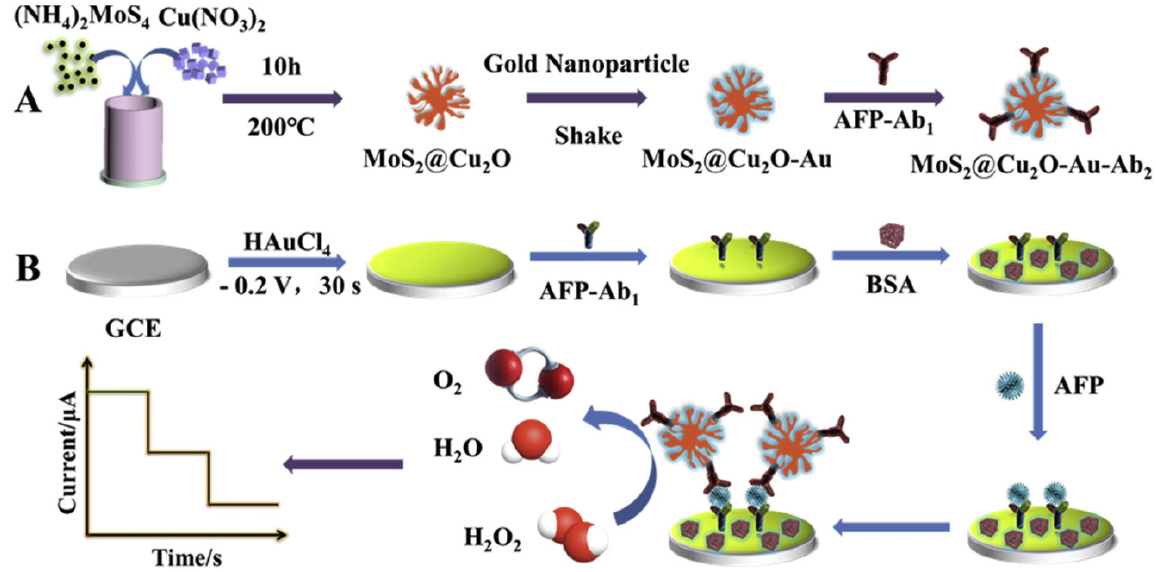
Figure 16. The schematic diagram for the preparation procedure for the sandwich-type electrochemical immunosensor. Reprinted with permission from Ref. [82]. Copyright 2019, Elsevier.